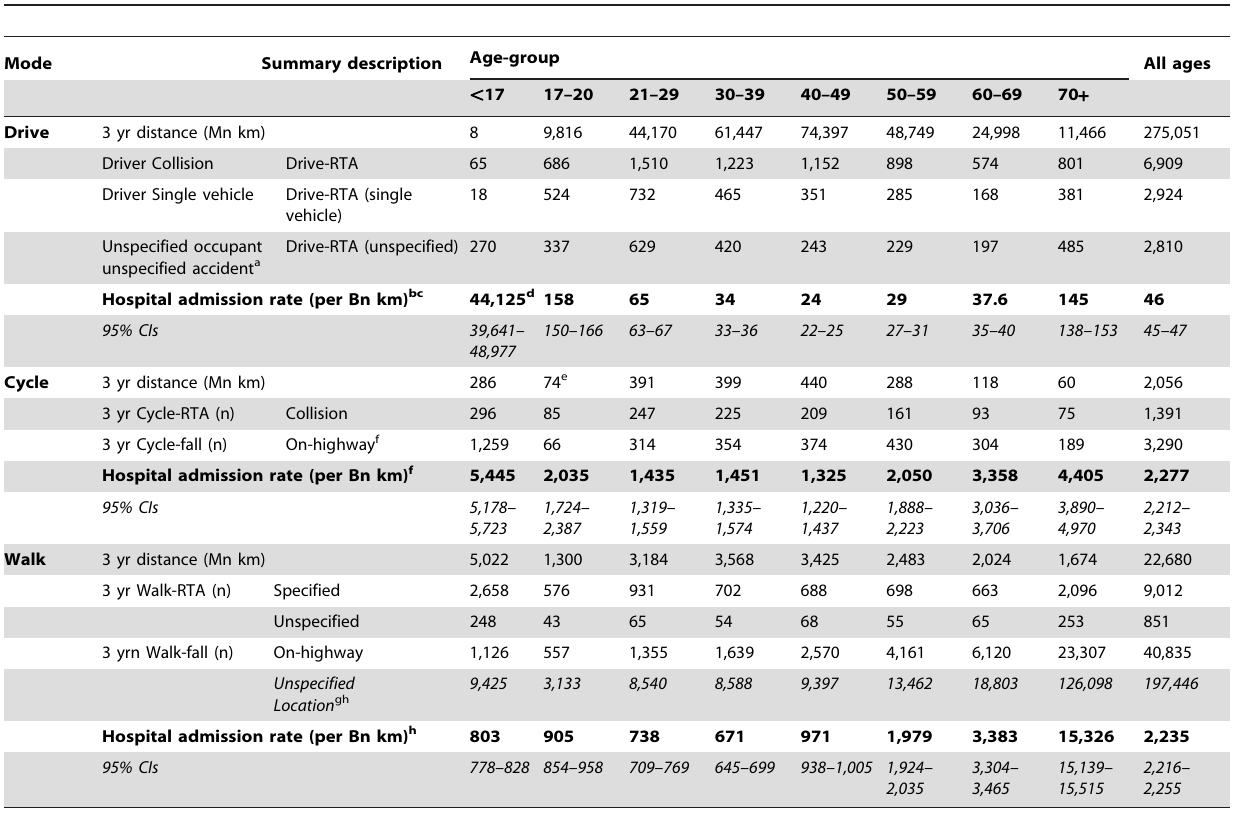
Table 4. Hospital admission numbers and rates per distance travelled, by travel mode, age, and type of incident, Females, England 2007–2009.